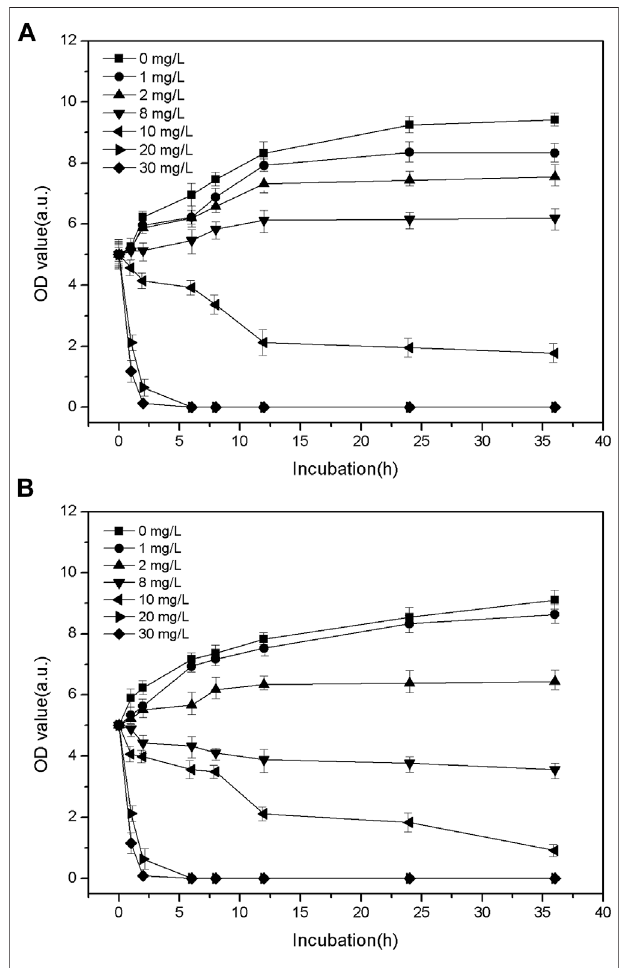
FIGURE 6 | Bactericidal kinetics curves of LY@ZnO against (A) E. coli and (B) S. aureus .